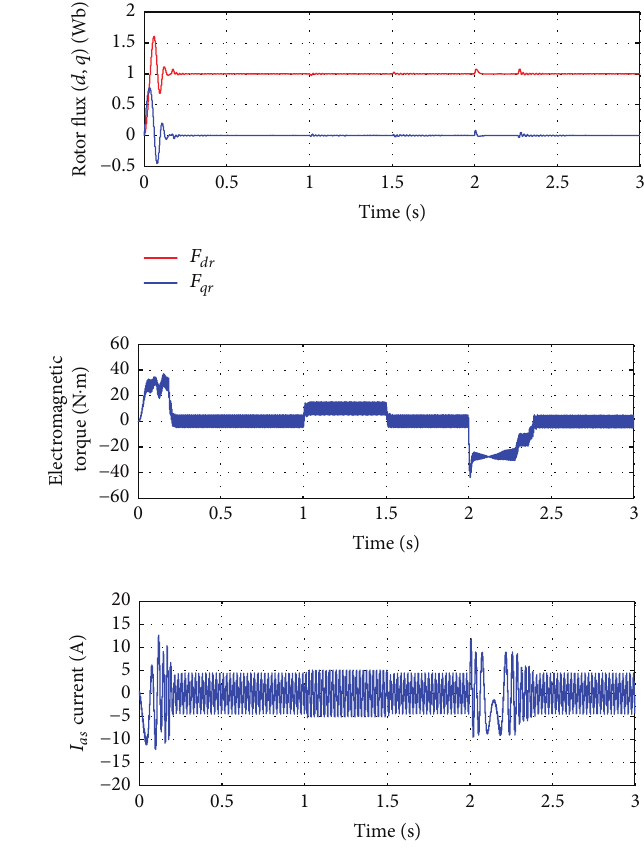
Figure 6: Control by regulating